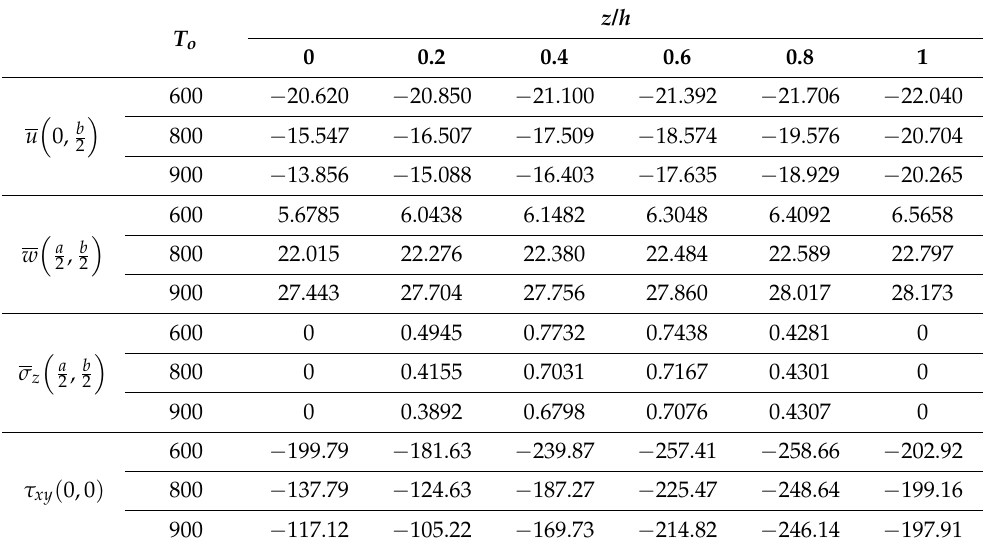
Figure 6. Effect of time constant variation, 𝜏 , on the transverse normal and shear stresses, as well as latitudinal displacement and transverse displacements. Table 3. Effect of different outer surface temperature, T o , on the transverse normal and in-plane shear stresses, as well as longitudinal displacement and transverse